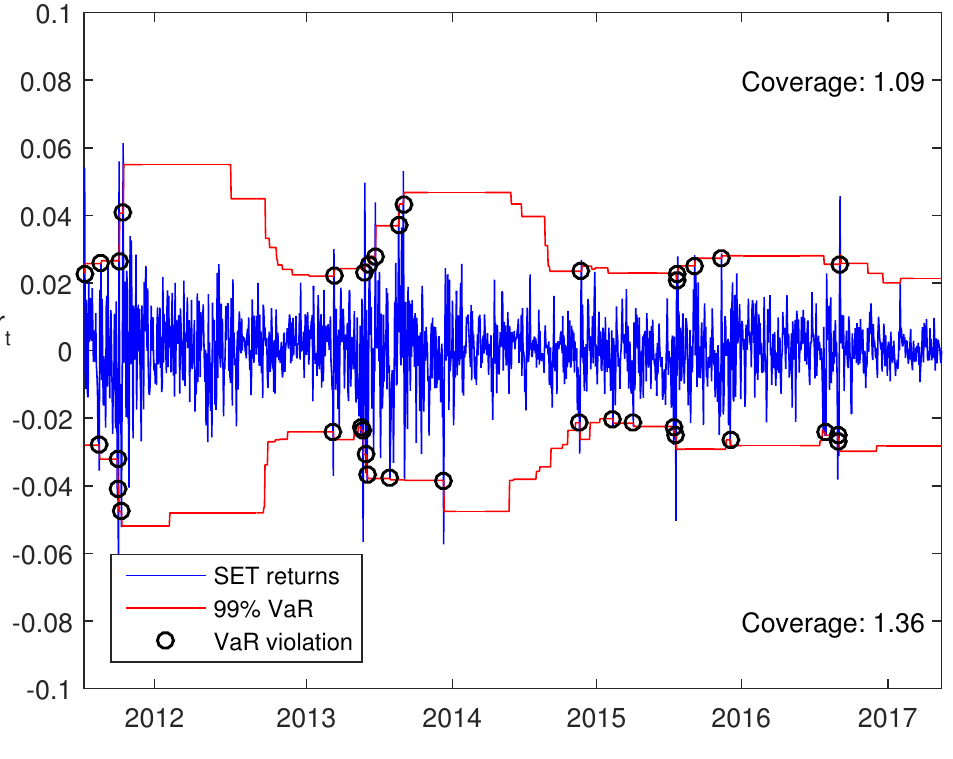
Figure 2. Value-at-Risk ( a = 1%) 1-day ahead forecast with Historical Simulation for the SET